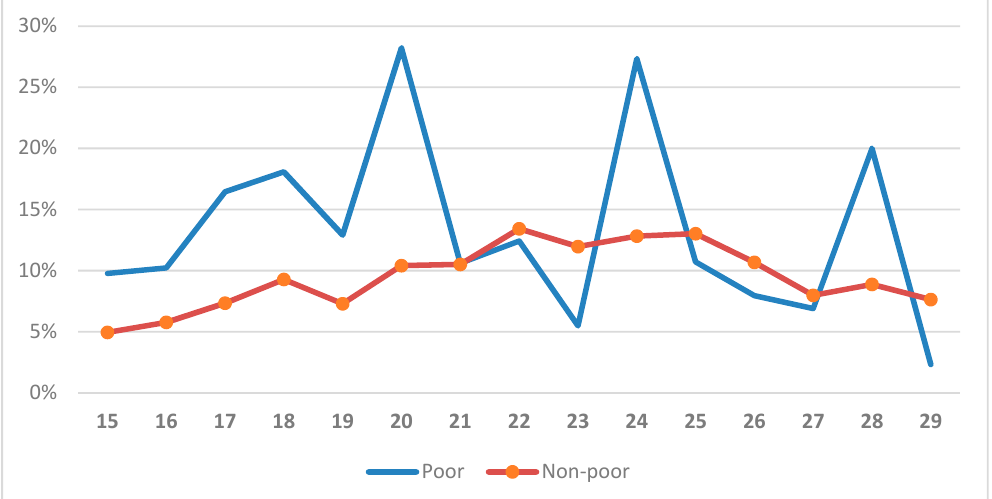
Figure 3. Unemployment rate by age and poverty status, 2013–2014. Note: Authors, data from HCP open data (www.hcp.ma) (accessed on 1 April 2022).